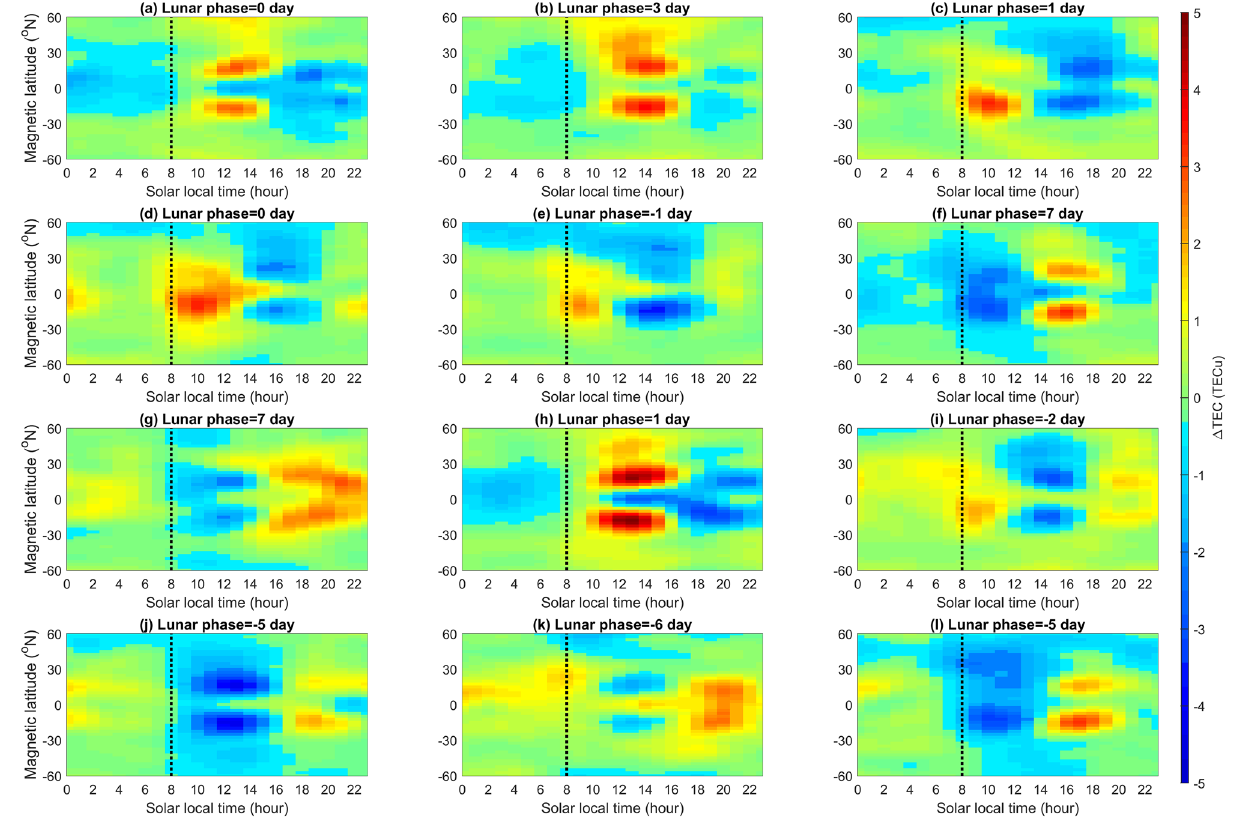
Figure 4. LTT plots on the same lunar phase day as the 12 CP07 SSW events but in the other 13 years. Each plot has been averaged over the 13